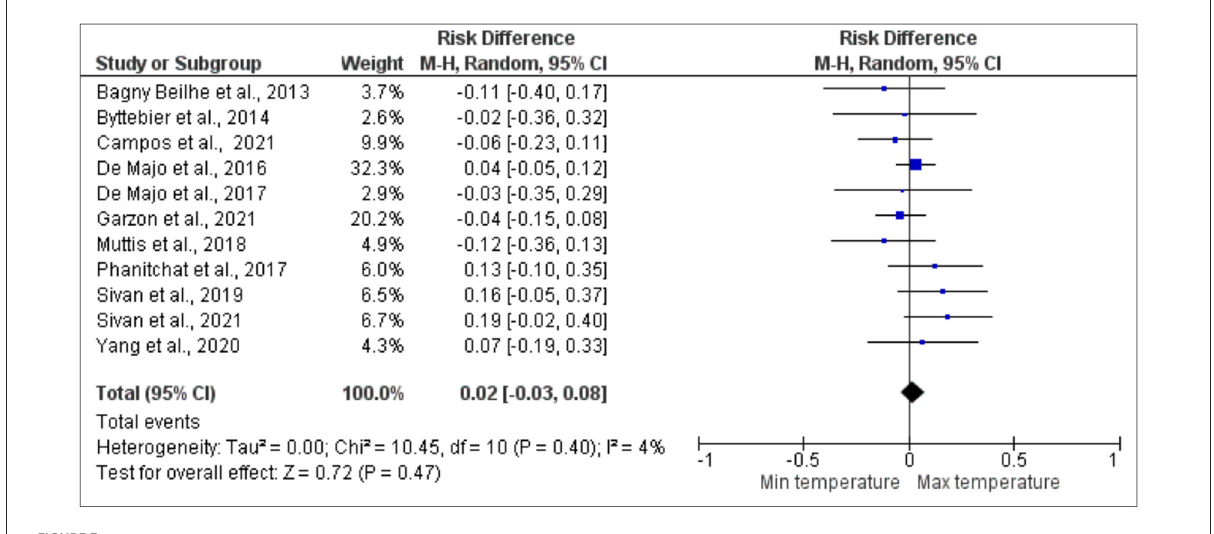
FIGURE3 Forest plot of comparison of the effect of minimum temperature vs. maximum temperature on the hatching rate of Aedes